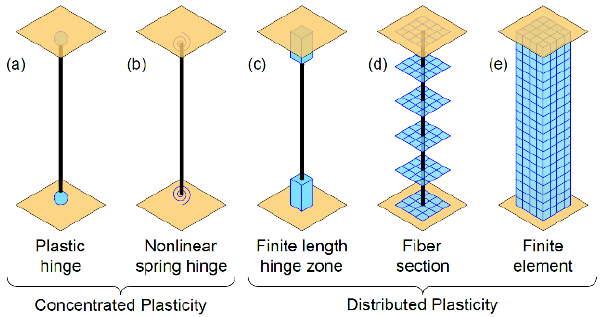
Figure 3. Idealized inelastic models of beams and columns, implemented as ( a ) plastic hinge, ( b ) nonlinear spring hinge, ( c ) finite length hinge zone, ( d ) fiber section and ( e ) finite element. Non-linear spring (NS), finite length hinge zone (FL) and fiber section (FS) models have